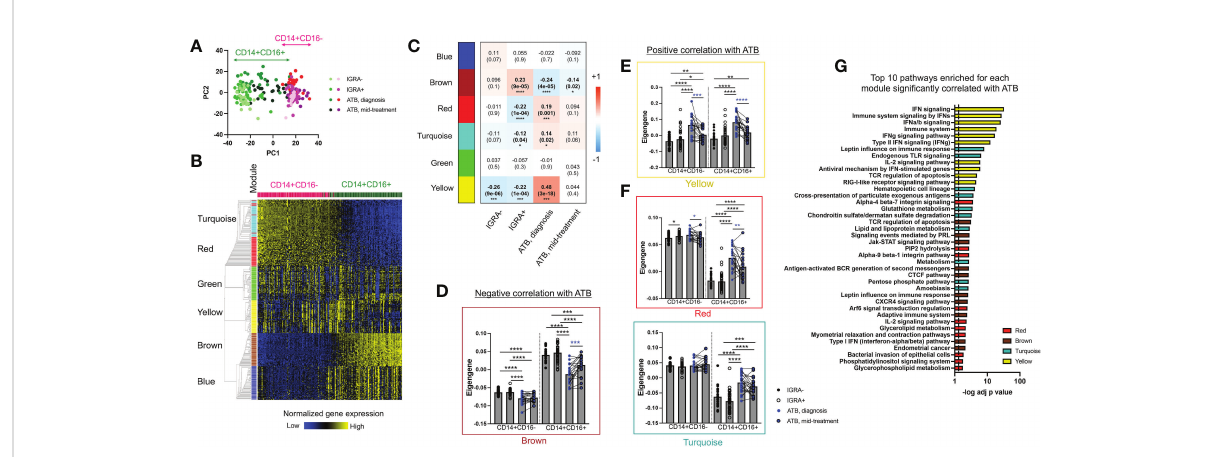
FIGURE 2 The CD14 + CD16 + population in ATB at diagnosis shows the highest transcriptomic changes compared to other cell populations and cohorts. (A) Principal component analysis of the transcriptome of CD14 + CD16 + and CD14 + CD16 - myeloid cells in active TB (ATB) at diagnosis, ATB mid- treatment, IGRA+ and IGRA- cohorts using their combined 1,000 most variable genes. Cells were sorted as de fi ned in Figure 1C and their transcriptomic pro fi le de fi ned by RNA sequencing. (B) Modular analysis of CD14 + CD16 + and CD14 + CD6 - cells using their combined 3,000 most variable genes and the WGCNA package (35). (C) Module trait-relationship analysis showing the Pearson correlation coef fi cient (and associated p-value in brackets) between each module and clinical cohort groups. Signi fi cant correlations are represented in bold. (D-F) Eigengene values for each module in ATB diagnosis, ATB mid-treatment, IGRA+ and IGRA- cohorts in CD14 + CD16 + and CD14 + CD6 - cells. Statistical comparisons between eigengene values were performed with nonparametric unpaired Mann-Whitney U test (black stars) and nonparametric paired Wilcoxon test (blue stars). (G) Pathway enrichment analysis for the yellow, turquoise, red and brown modules identi fi ed in Figure 2 which showed signi fi cant changes in expression in ATB at diagnosis compared to IGRA+/- cohorts. The top 10 pathways are displayed, ranked by their decreasing p-value and the full list of pathways for each module is available in Table S5. Data was from cryopreserved PBMC of 25 ATB subjects at diagnosis (with 22 paired mid-treatment samples), 40 IGRA+ and 20 IGRA- individuals. *p < 0.05, **p < 0.01, ***p < 0.001, ****p <